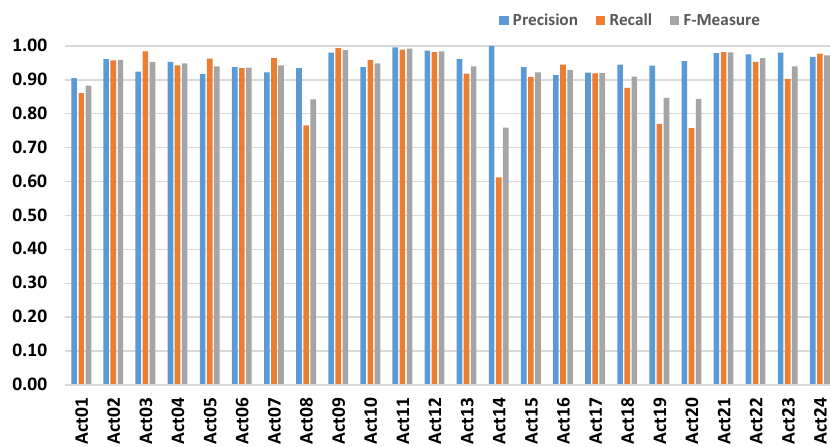
Figure 5. Evaluation for the Training